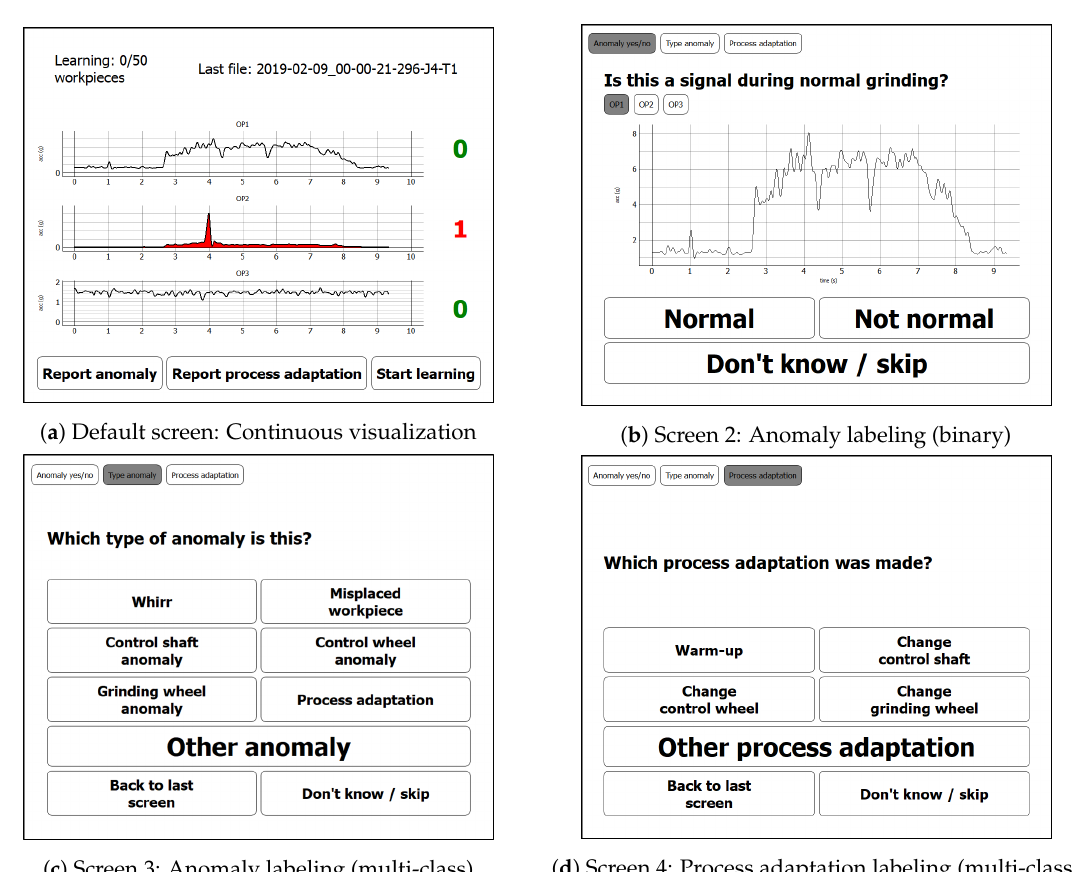
Figure 4. Screens of the visualization and labeling prototype (English version): The figures illustrate screenshots of the developed labeling prototype which was deployed on the factory floor. A detailed description of the functional workflow of the screens can be found in Section